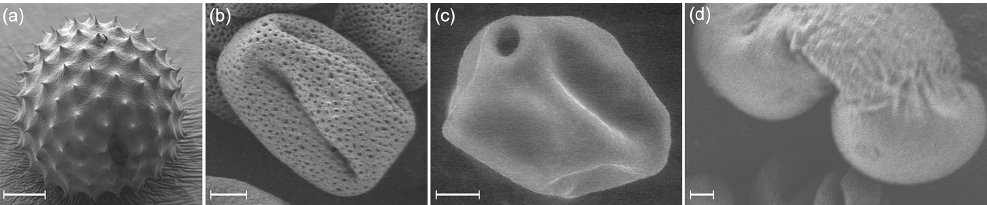
Figure 1. Scanning electron microscopy (SEM) images of the studied pollen taken at the Institute of Light and Matter: (a) ragweed ( Ambrosia artemisiifolia ), (b) ash ( Fraxinus americana ), (c) birch ( Betula pendula ), (d) pine ( Pinus strobus ). The scale bar is 5µm on all pictures. Pollen grains were suspended in ambient air and deposited on an adhesive substrate for SEM